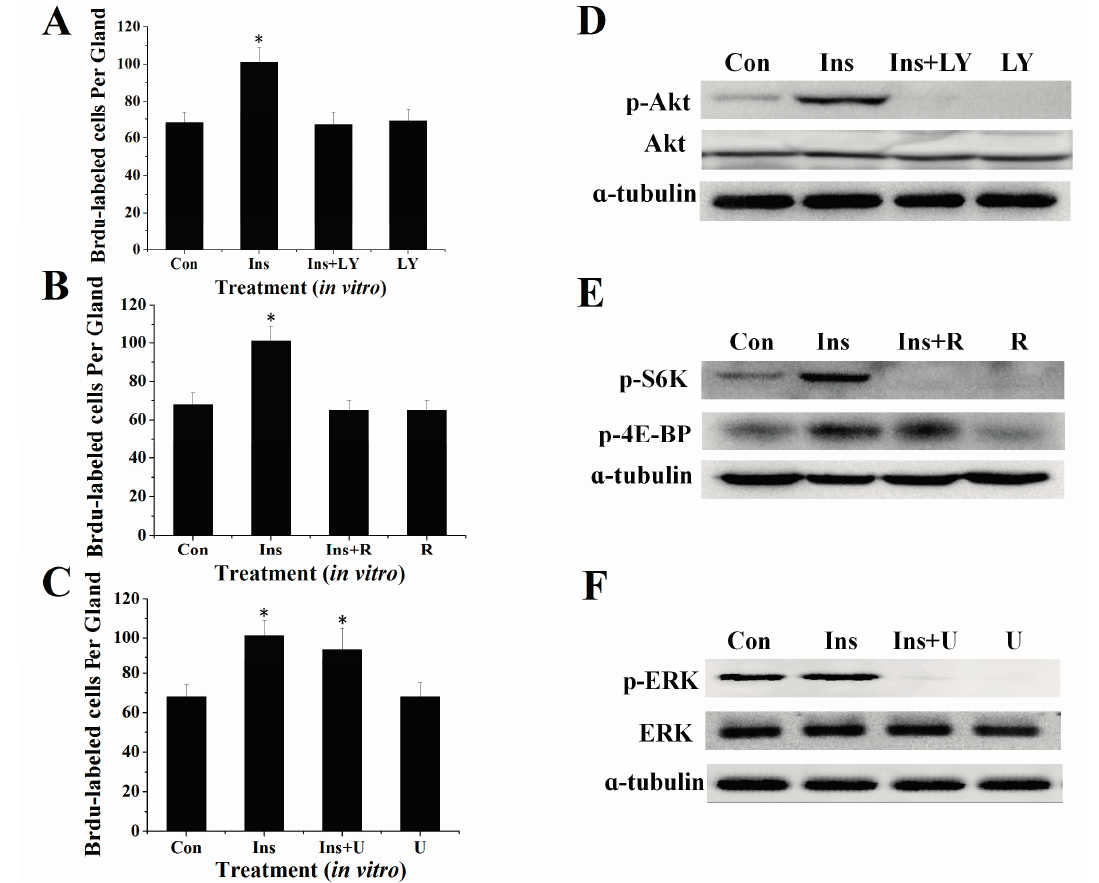
Figure 3. Insulin-activated DNA synthesis of silk gland cells is dependent on PI3K/Akt and TOR signaling, but not ERK signaling. The silk glands of day 1 fourth instar larvae were preincubated with LY294002 (48.8 μ M), rapamycin (5.5 μ M) or U0126 (21 μ M) for 45 min and then incubated with medium containing insulin (1.74 μ M) with or without LY294002 (48.8 μ M) ( A ), rapamycin (5.5 μ M) ( B ) or U0126 (21 μ M) ( C ) for 1 h. The silk glands were labeled with BrdU and then analyzed. After preincubation for 45 min, the silk glands were incubated with medium containing 1.74 μ M insulin with or without LY294002 ( D ), rapamycin ( E ) or U0126 ( F ) for 15 min. Silk gland lysates were prepared and subjected to an immunoblot analysis with their corresponding antibodies. The results shown are representative of three independent experiments. Con: control; Ins: insulin; LY: LY294002; R: rapamycin; U: U0126. * p < 0.05. 2.4. PI3K/Akt Signaling Is an Upstream Signaling Pathway for Insulin-Activated TOR Signaling The relationship between PI3K and TOR signaling was also investigated in the silk glands in the above-described manner. Western blot analysis showed that the PI3K inhibitor, LY294002, reduced levels of insulin-induced S6K and 4E-BP phosphorylation (Figure 4A). To determine whether TORC1 functions upstream or downstream of Akt, we examined the effects of rapamycin on the insulin-induced phosphorylation of Akt. The results showed that rapamycin did not inhibit Akt phosphorylation (Figure